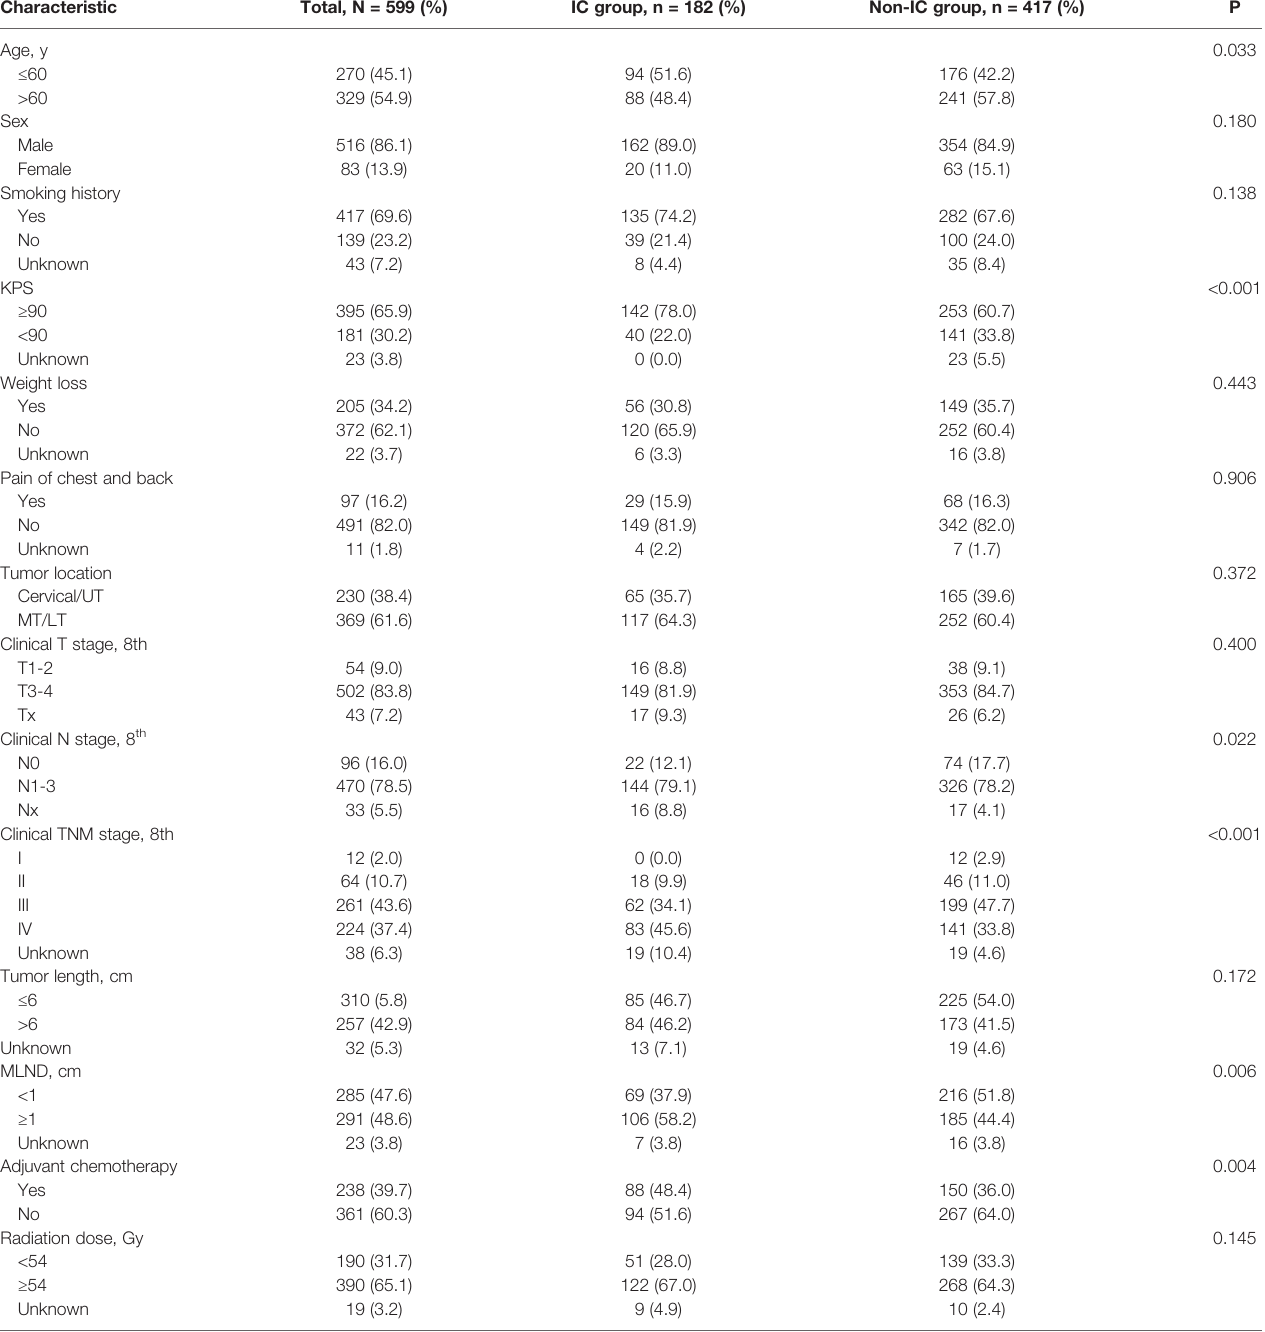
TABLE 1 | Patient